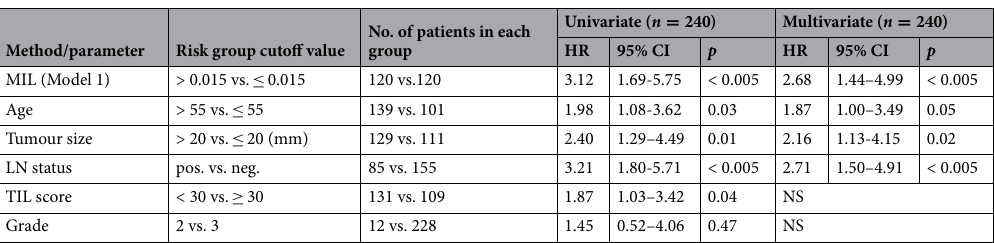
Table 4. Univariate and multivariate analysis for breast cancer specific survival for the full dataset of TNBC patients using Model 1 output. NS not significant.